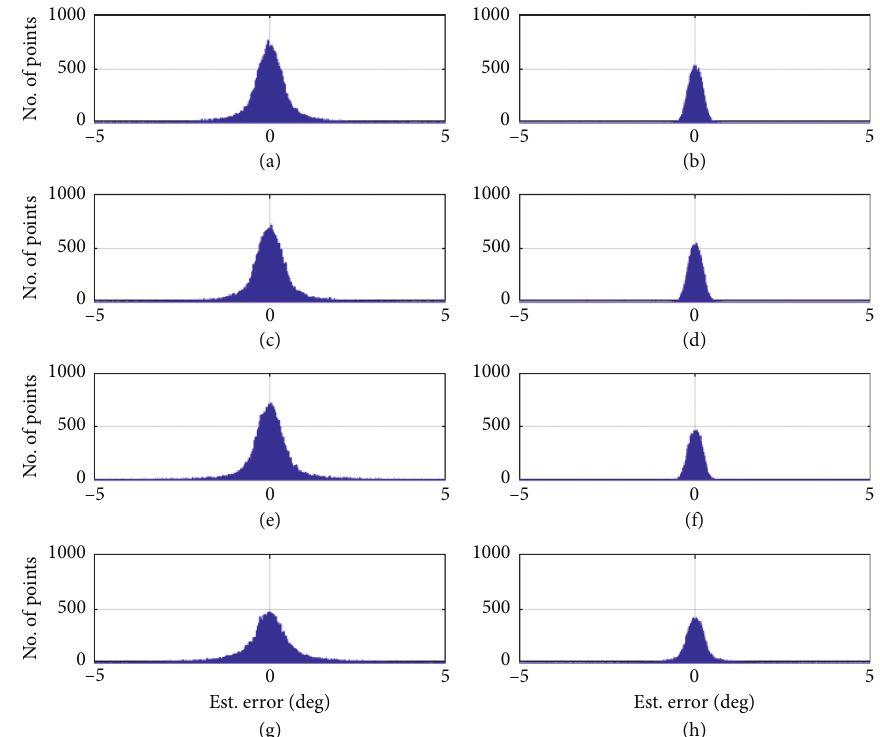
Figure 11: The histograms of Az (left column) and El (right column) estimation errors, when 0dB ≤ SNR ≤ 10dB with 1025 snapshots. (a, b) WF-1; (c, d) WF-2; (e, f) WF-3; (g, h)